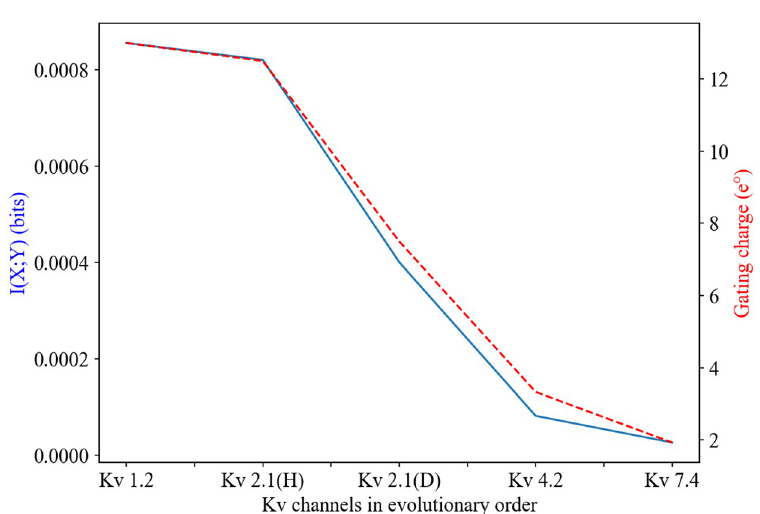
Fig 7. Decrease in mutual information is closely related to decrease in gating charge in Kv channel evolution. The mutual information in a normally distributed environment (blue) is used as an example, but the correlation with gating charge is similar in all other